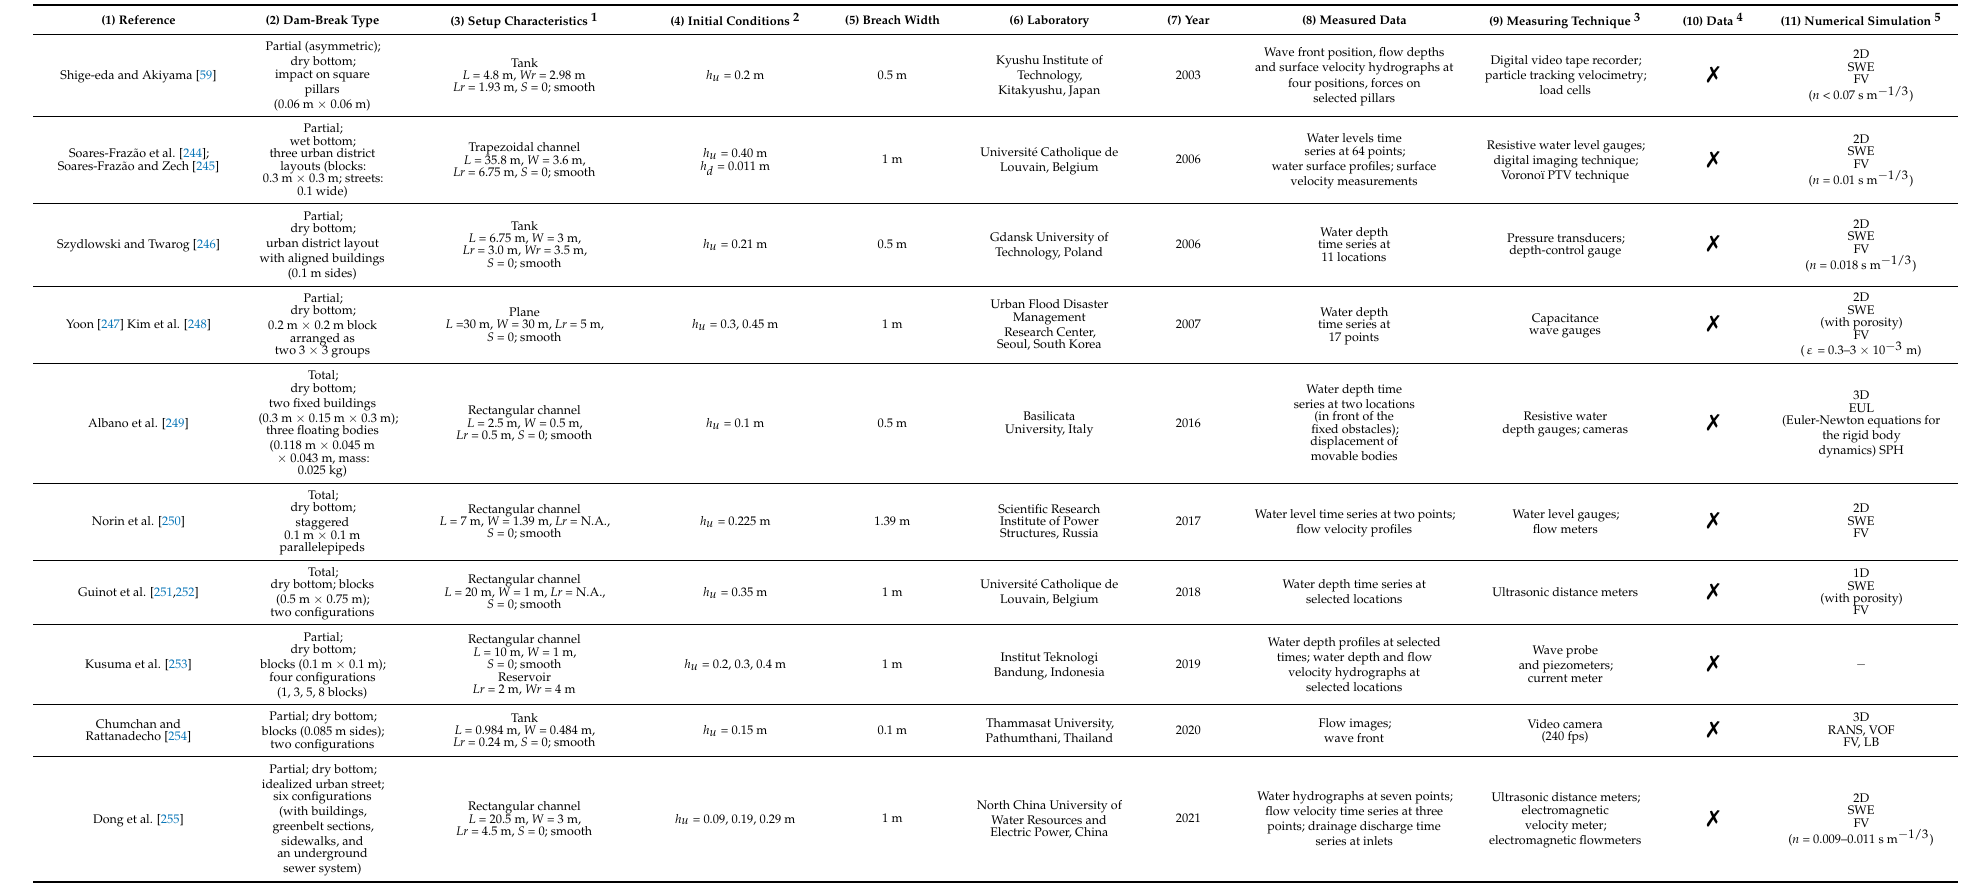
Table 1. Basic experimental investigations of fundamental dam-break wave physical characteristics.